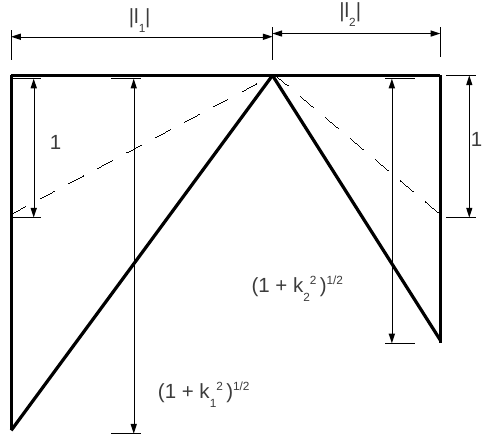
Fig. 3. Geometric representation of the resonance condition (31). Hypotenuses of the right-angle triangles (solid) represent the two entries in the l.h.s., with their minimal values also shown